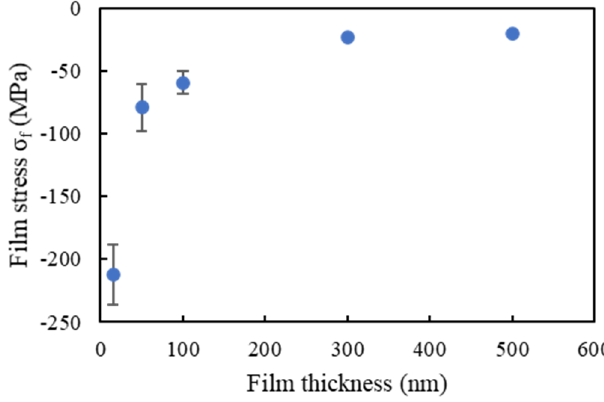
Figure 6. Residual stress in Au thin films as a function of film thickness.